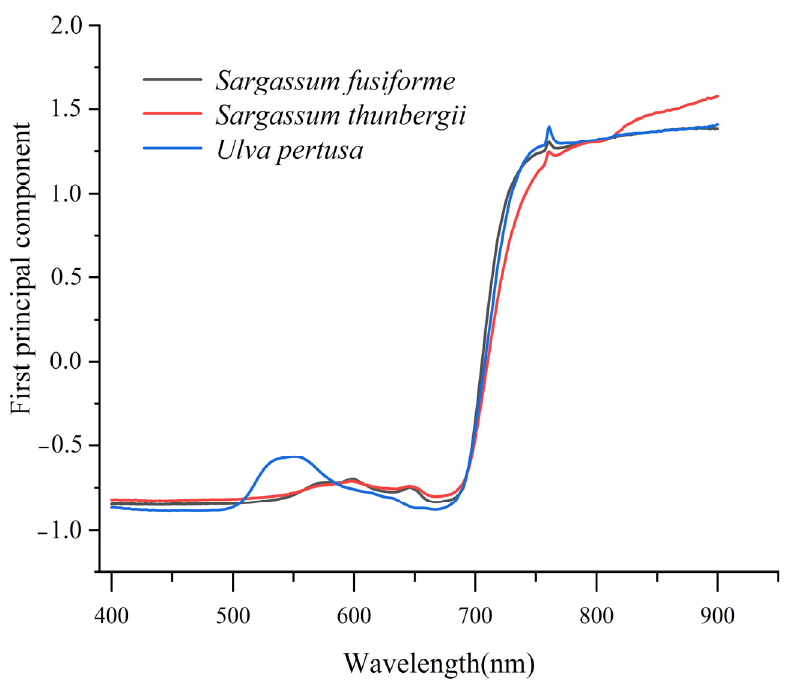
Figure 7. Spectral reflectance of the first principal